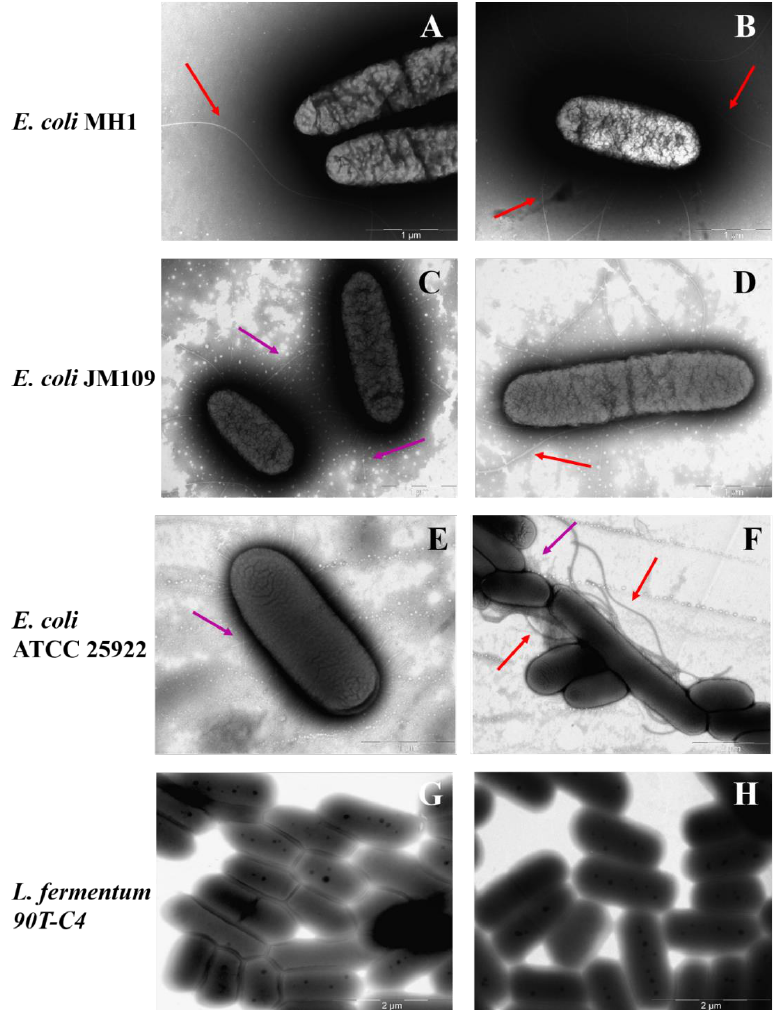
Figure 8. The morphology of bacterial surface: E. coli MH1 ( A , B ), E. coli JM109 ( C , D ), E. coli ATCC 25922 ( E , F ), L. fermentum 90T-C4 ( G , H ). Purple arrows indicate fimbria and red arrows indicate fla- gella. Scale bars: 1 μm ( A – E ) and 2 μm ( F – H ).